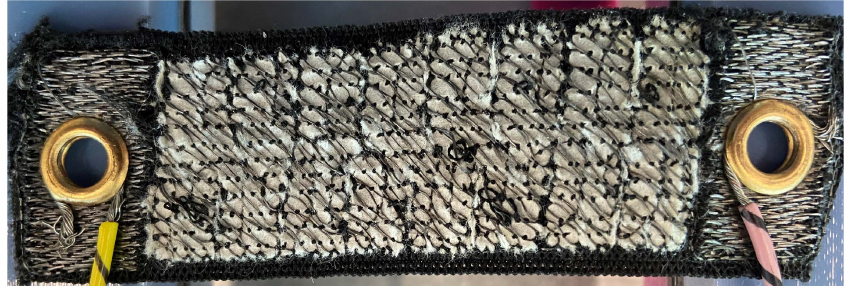
Figure 6. The embroidered textile strain sensor with dimensions of 90 by 25 mm. Wires are attached to each end of the sensor using